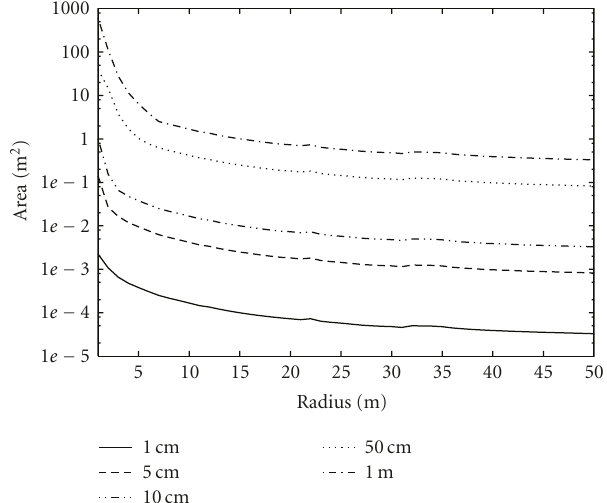
Figure 16: Uncertainty area for N = 3 receivers and θ = π/ 2, as a function of the radius r and for di ff erent annulus thickness